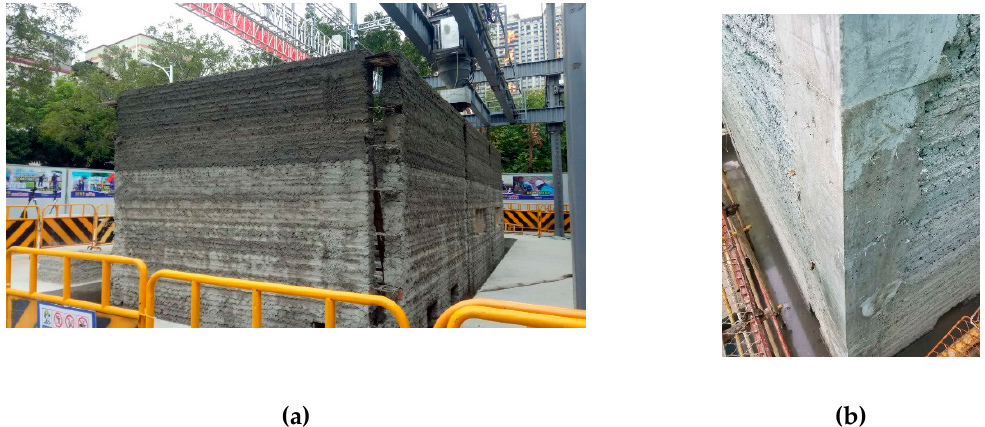
Figure 9. Constructional columns ( a ) Reserved position for constructional columns during printing and ( b ) Constructional columns after casting.